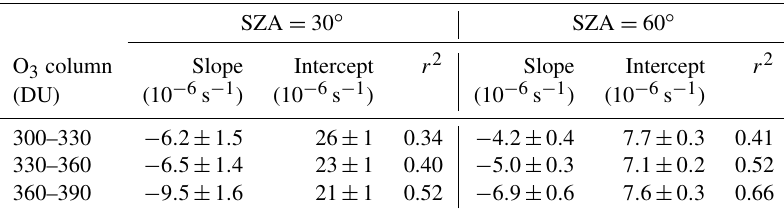
Table 3. Slope, intercept, and the square of correlation coefficient ( r 2 ) of linear fits of correlation between j (O 1 D) and AOD for each ozone column class at AOD smaller than 0.7.